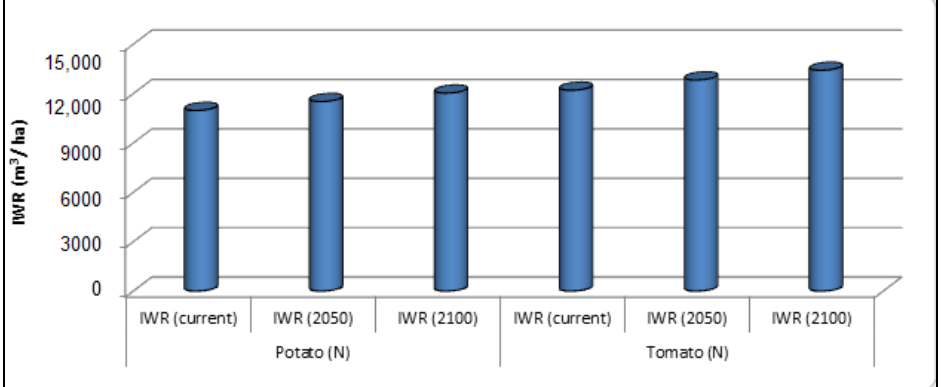
Figure 9. Average irrigation water requirements (IWR) for some Nili crops in Middle Egypt under current and climate change conditions over 30 years.